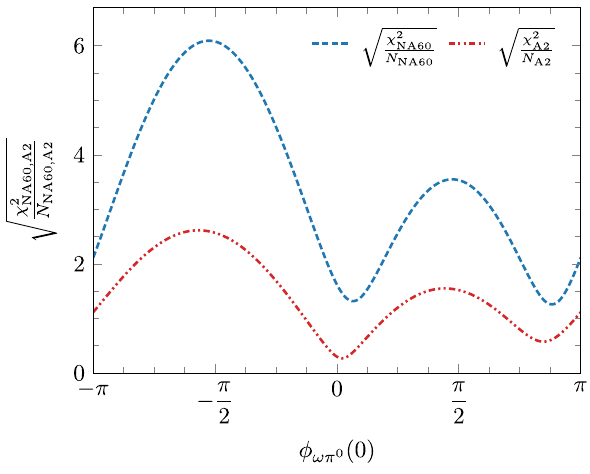
Fig. 4 Dependence of the χ 2 functions on the phase φ ωπ 0 ( 0 ) for NA60,A2 fixed values of the other free parameters, as described in the